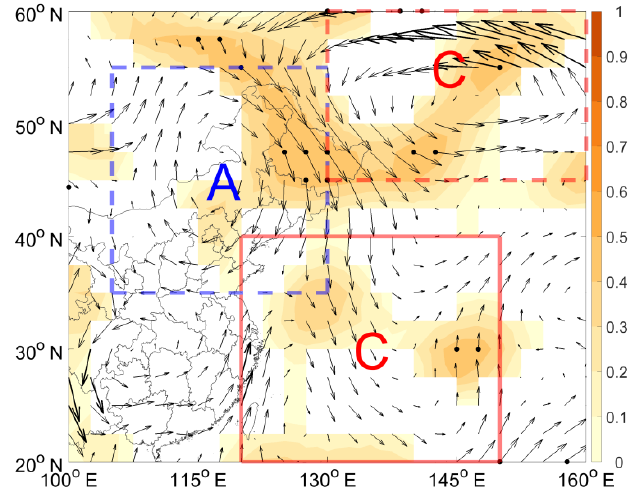
Figure 6. Spatial distribution of the correlation coefficients between SST in region A for the preceding winter and the following summer 700 hPa wind vector field (arrow, unit: m · s − 1 ) and 700 hPa vertical velocity field (ω) (×100, shadow, unit: Pa·s − 1 ) (A: anticyclonic circulation; C: cyclonic circulation; solid wireframe: region A; dotted box: region of dipoles of medium and high latitude in East Asia).